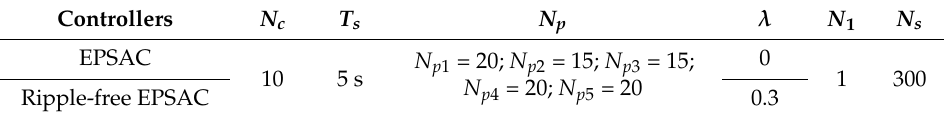
Table 2. Parameters applied in Extended Prediction Self-Adaptive Control (EPSAC) controller.